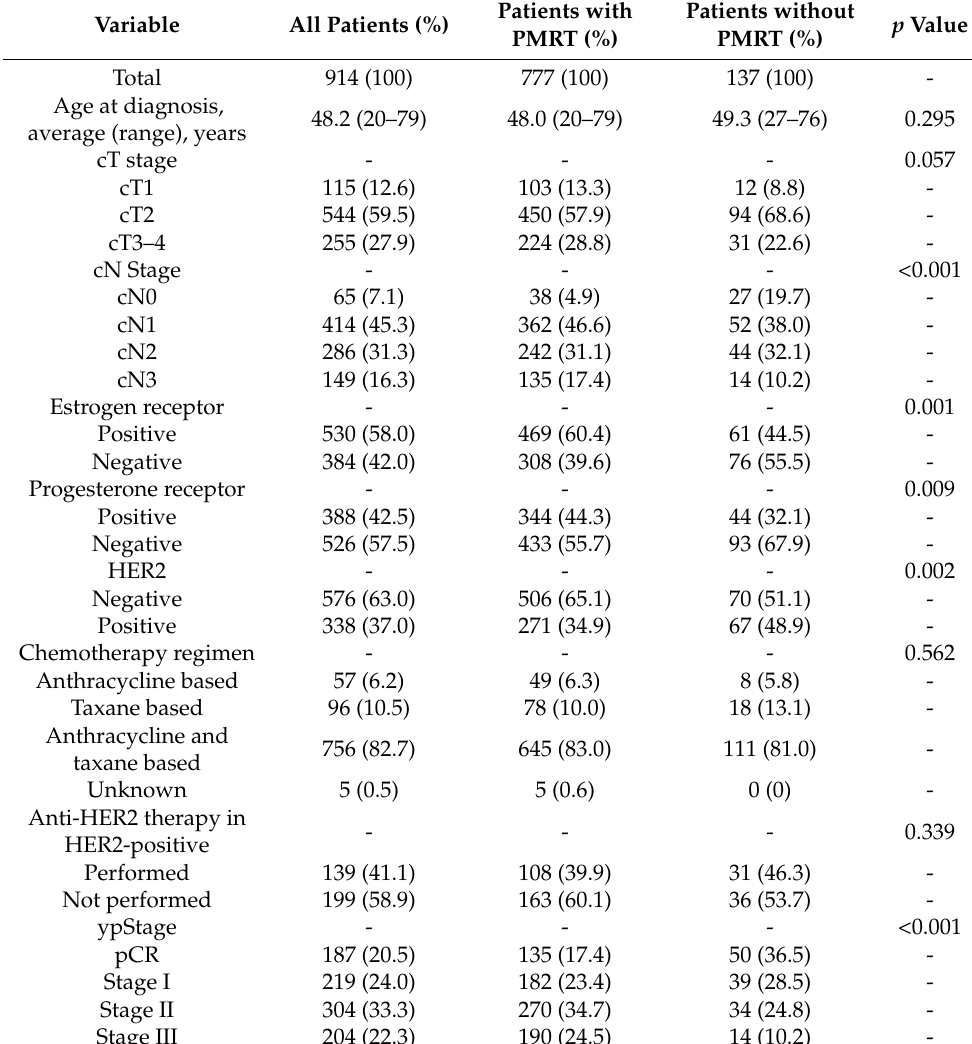
Table 1. Baseline characteristics of all patients with or without